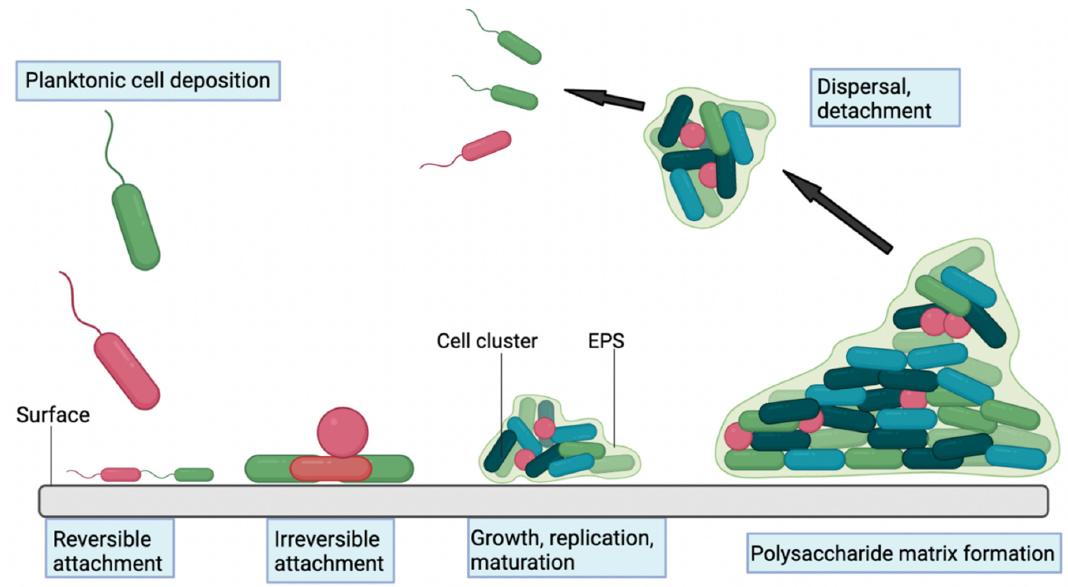
Figure 1. Schematic representation of the main steps in biofilm formation on a surface. Biofilm formation is a cyclic process that begins with surface contact by single planktonic cells. Cells go through reversible attachment whereby bacteria attach to a surface via their flagella or cell pole, to irreversible attachment when flagella reversal rates decrease, and biofilm matrix component production occurs. Biofilm maturation follows, and dispersion occurs due to extracellular polymeric substance (EPS) degradation. Created with BioRender.com.